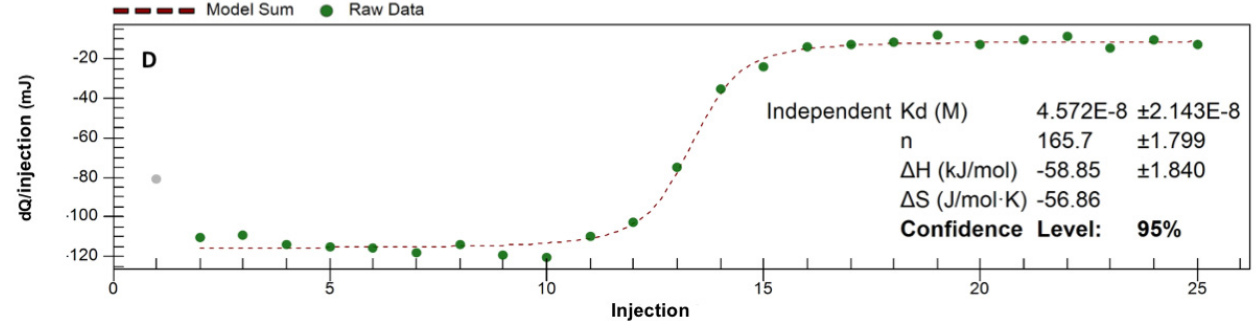
Figure A1. ITC data for the binding of lysozyme onto PCPP (direct titration): incremental heats of each injection are shown with the fit for the one-site binding model (0.125 PCPP solution was titrated with 2.5 mg/mL lysozyme; PBS, pH 7.4.).